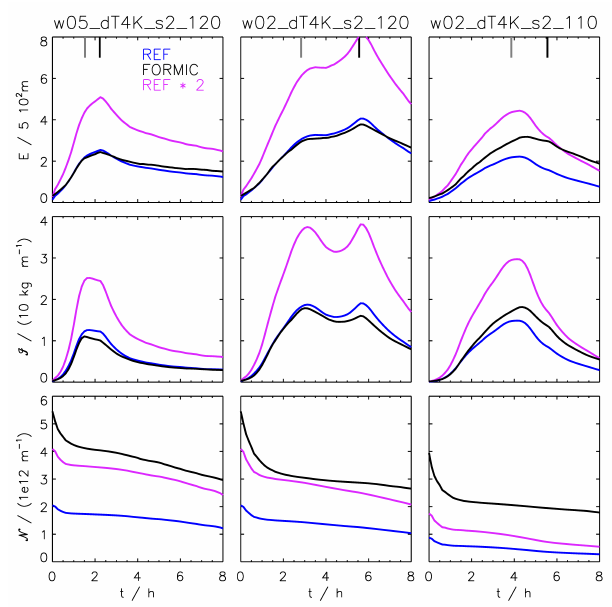
Figure 6. As in Figure 5, now for ∆ T = 4K scenarios with natural cirrus emerging around the contrail-cirrus. Unlike to Figure 5, no NNN simulations have been performed and neither optical thickness nor contrail width are shown. The grey bar additionally indicates the onset of natural cirrus formation.